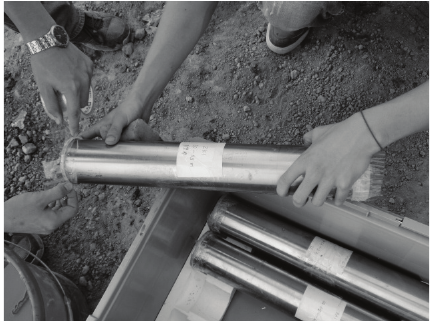
Figure 8: Cylindrical